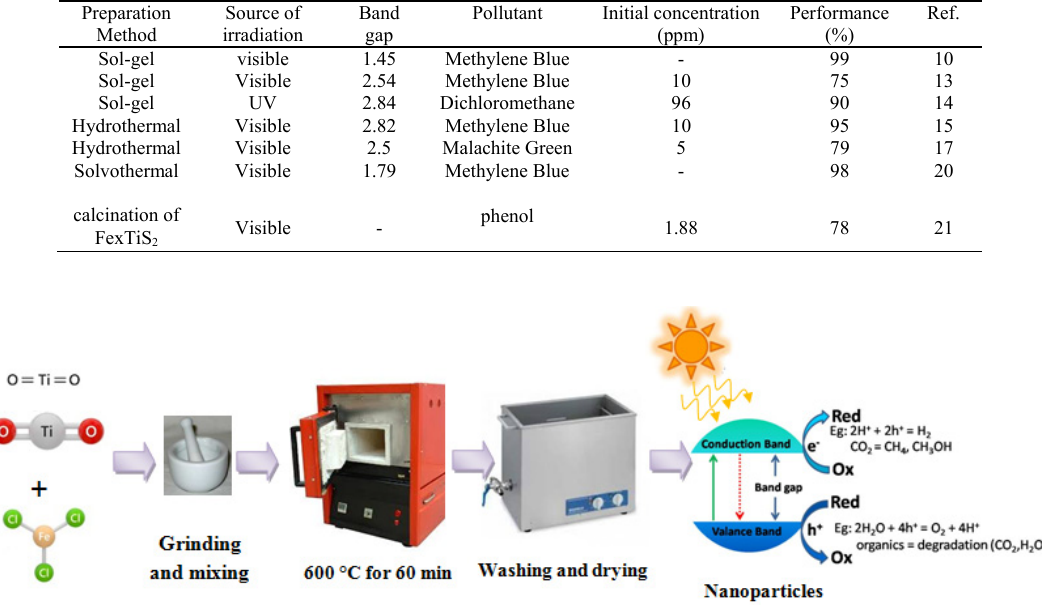
photocatalysts 2